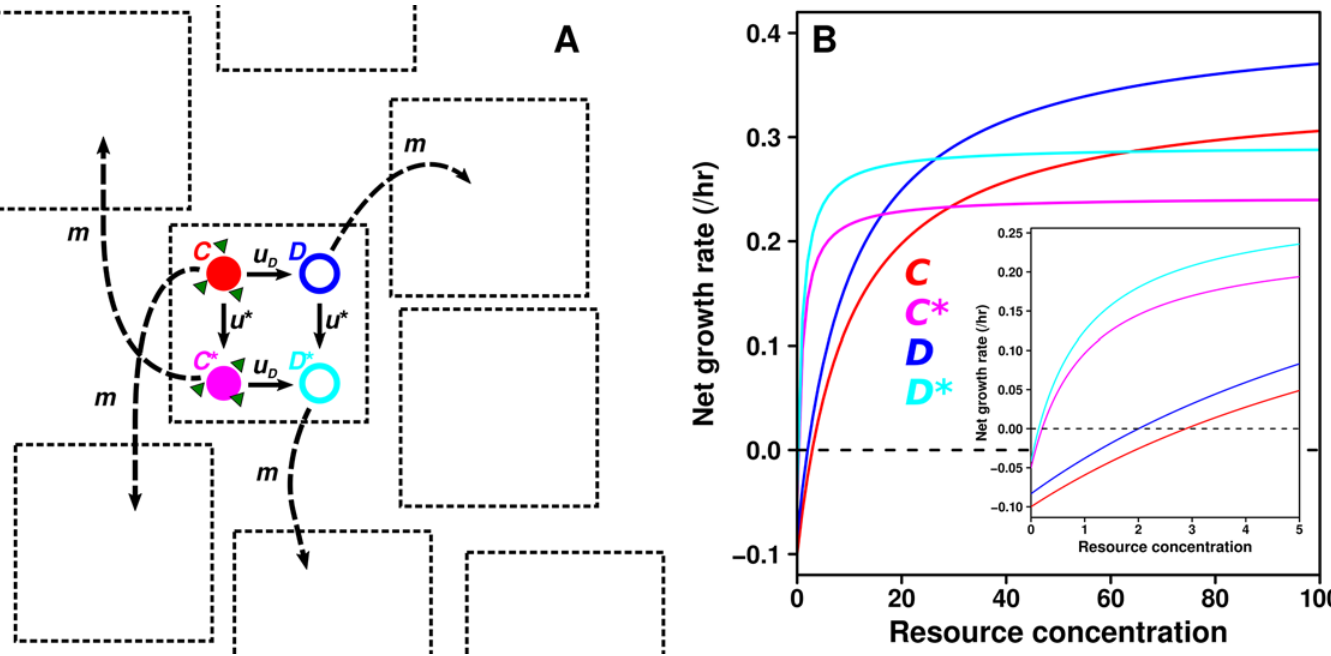
Fig 1. A social dilemma defined by resource use and fitness trade-offs. A ) Model overview. Ancestor types mutate to evolved types (denoted by a ' * ') at rate u * . Cooperators ( C and C * ), which produce resource (green triangles) mutate at rate u D to defectors ( D and D * ), which produce nothing. All types migrate randomly to new locations at rate m . B ) When resource is abundant, C (red) and D (blue) have faster net growth rates than C * (magenta) and D * (cyan). When resource is low, C * and D * grow faster than C and D . However, the net growth rate of D is always greater than C , and the net growth rate of D * is always greater than C * , resulting in a social dilemma. (Inset) The fitness functions at low resource levels.